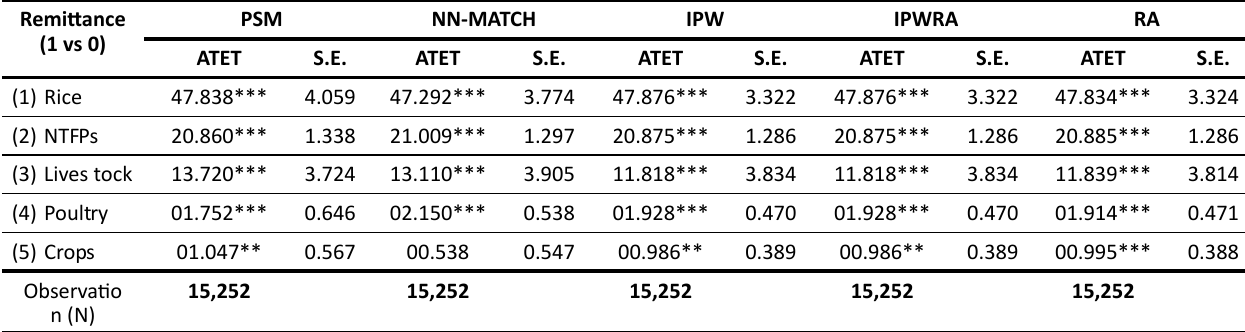
Table 8: ATET Estimation: Impact of Remittances on Mutual Transactions Remittance (1 vs